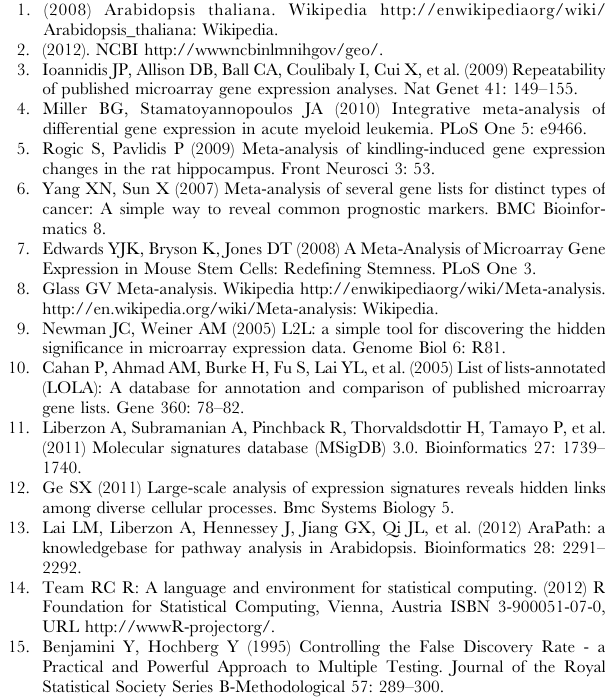
corresponding to cluster 4. Table S5. Results of sub-network 5 corresponding to cluster 5. Table S6. Results of sub-network 6 corresponding to cluster 6. Table S7. Results of sub-network 7 corresponding to cluster 7. Table S8. Results of sub-network 8 corresponding to cluster 8. Table S9. Results of sub-network 9 corresponding to cluster